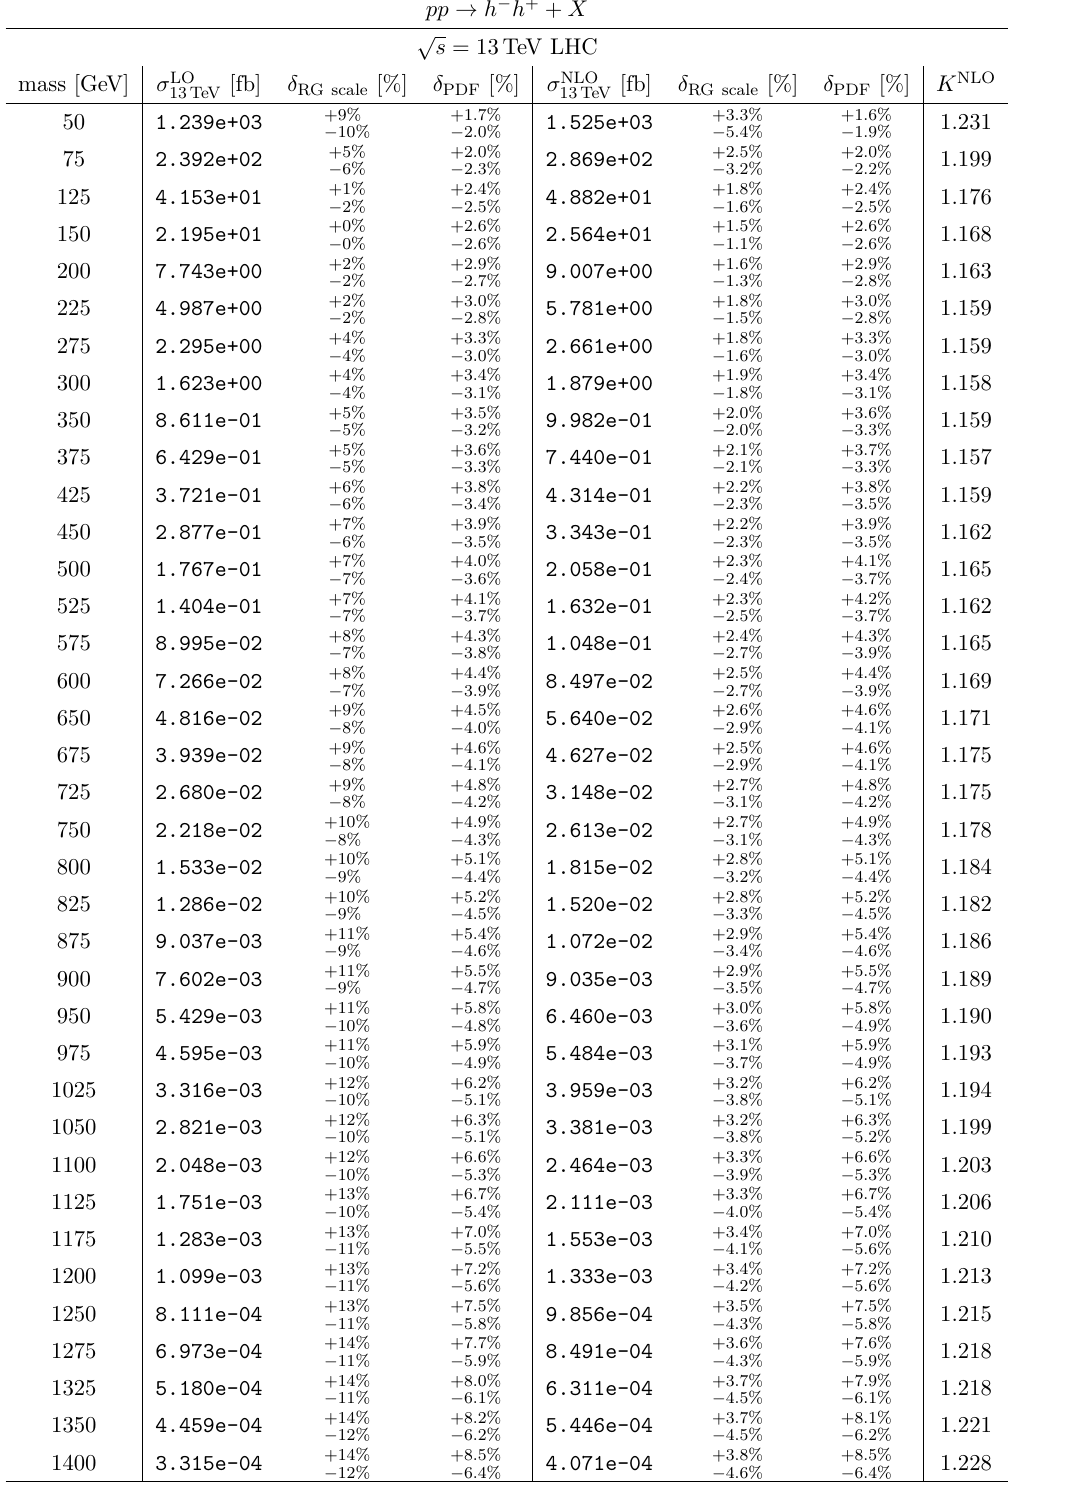
Table 7 . For representative masses m h [GeV] (first column), the predicted cross sections [fb] for √ s = 13 TeV at LO (second column) and NLO (third column) in QCD for inclusive pp → h − h + + X via the Drell-Yan process (DY). Also shown are scale uncertainties [%], PDF uncertainties [%], and the QCD K -factor. See section 3.2 for SM